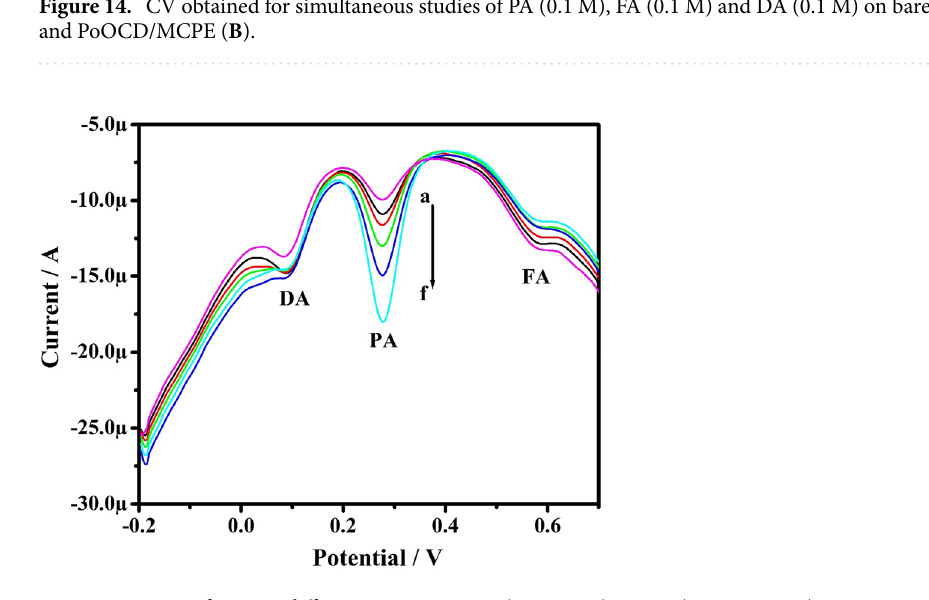
Figure 15. DPVs for PA at different concentrations (10–60 µM) in PBS (0.2 M, pH 7.4) at SR 50 mVs −1 at